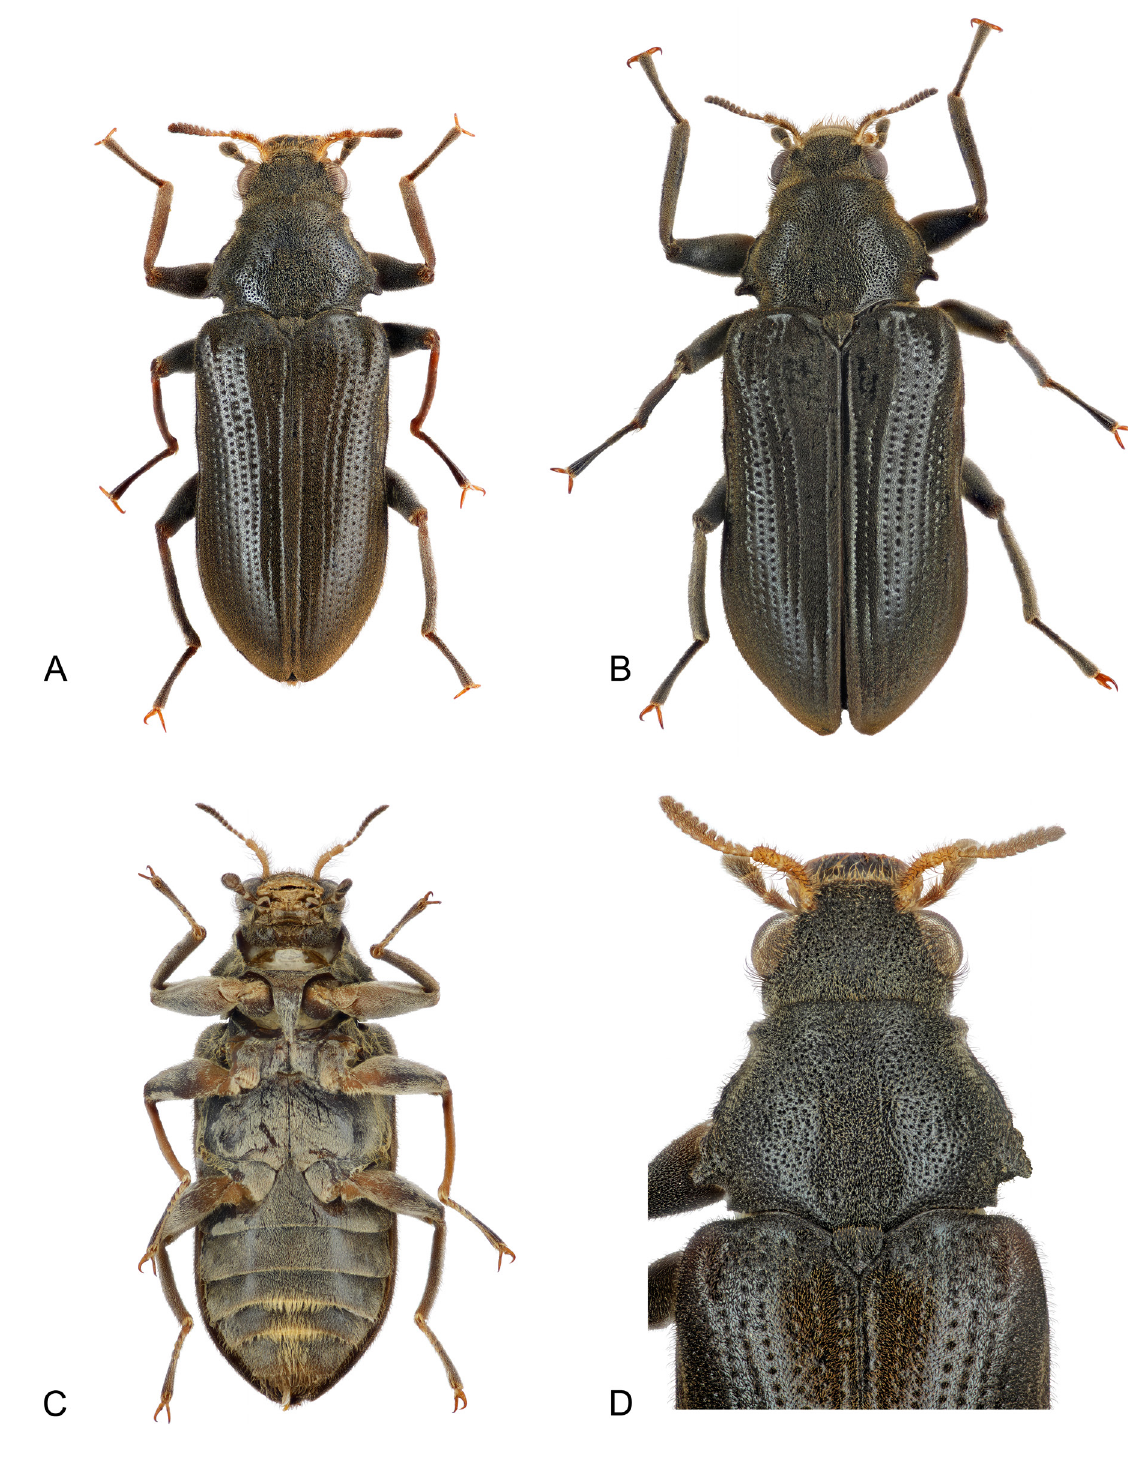
Fig. 2. Potamophilus kelabitensis sp. nov. A . Male holotype (CFDS), dorsal view, length from anterior margin of clypeus to elytral apex: 5.90 mm. B . Female paratype (CKB), dorsal view, length from anterior margin of clypeus to elytral apex: 7.31 mm. C . Male paratype (CKB), ventral view. D . Detail of the head, pronotum, and anterior portion of elytra, male paratype